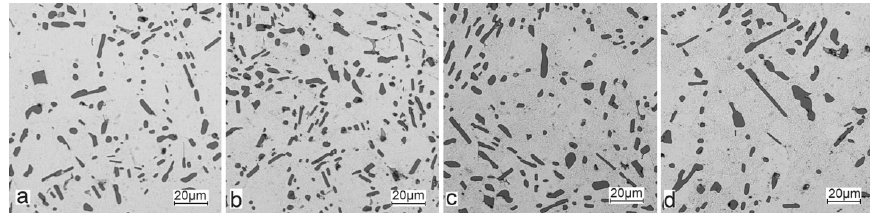
Figure 8. Microstructure of AlSi10 alloy with Sn addition after T6 treatment—mag. 500×: ( a ) AlSiSn0.2; ( b ) AlSi10Sn0.4; ( c ) AlSi10Sn0.7; ( d ) AlSi10Sn1.7.